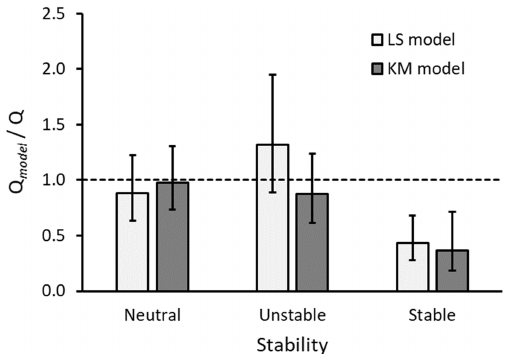
Figure 3. Agreement ratio of the footprint-model-calculated emis- sion rate ( Q model ) to actual release rate ( Q ), grouped by atmo- spheric stability: neutral ( | L | > 60m), unstable (0 > L > − 60), and stable (60 > L > 0). Calculations are from the LS and KM models. The columns show the geometric mean, and the error bars show the 95% confidence interval of the mean. The dashed horizontal line represents a Q model /Q ratio of 1, or a perfect model